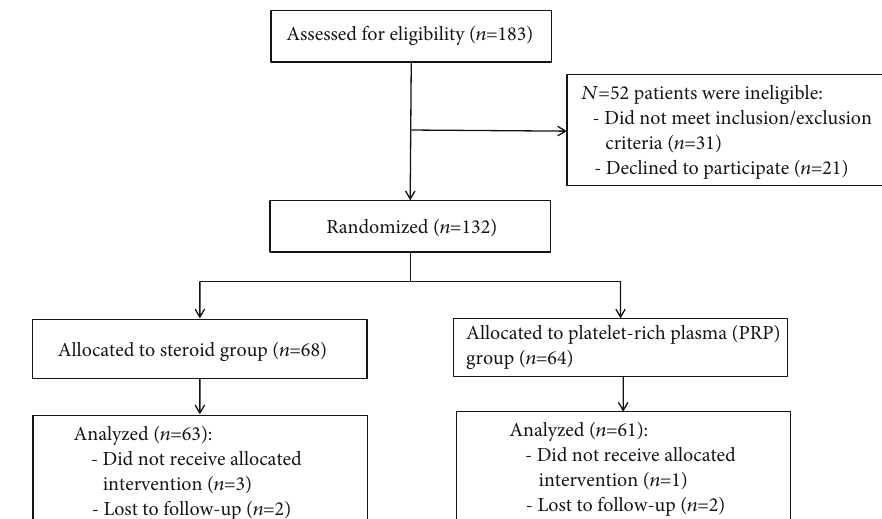
Figure 1: Flow diagram of enrolment, randomization, and analysis.